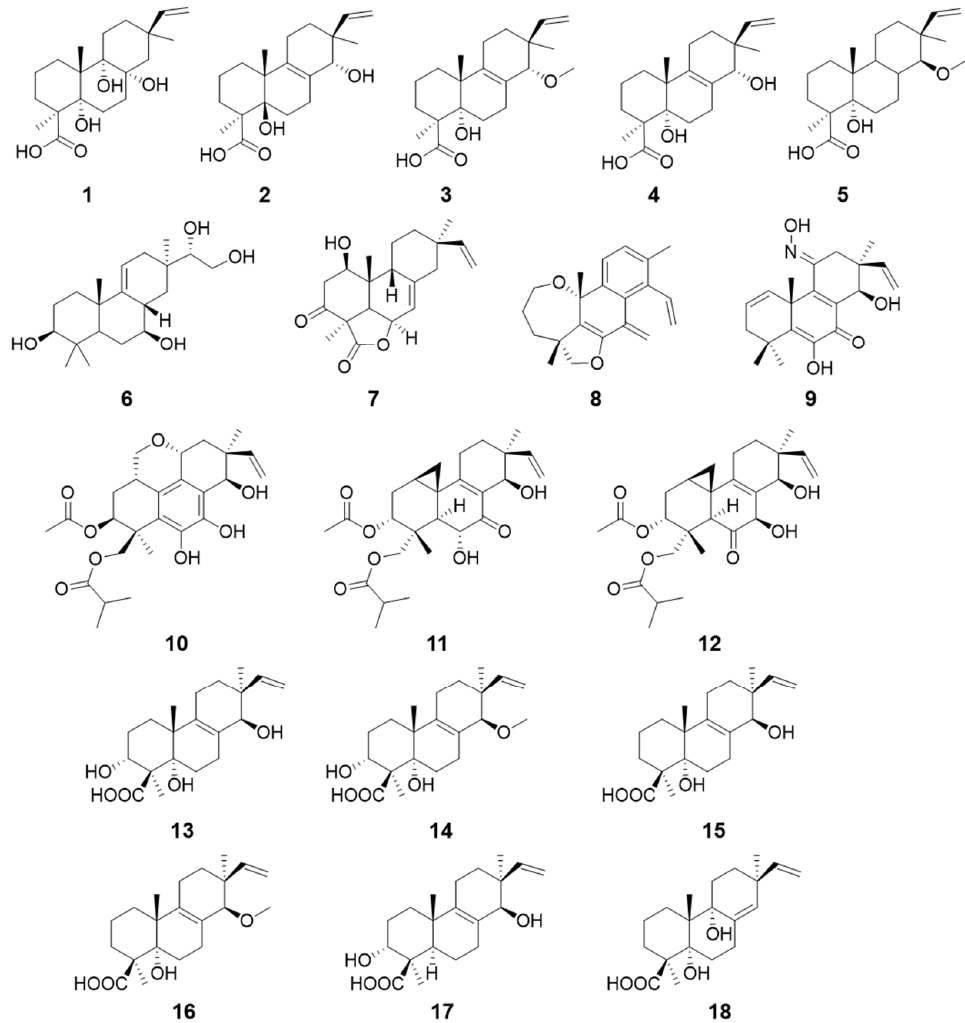
Figure 2. Structures of compounds 1 – 18 .